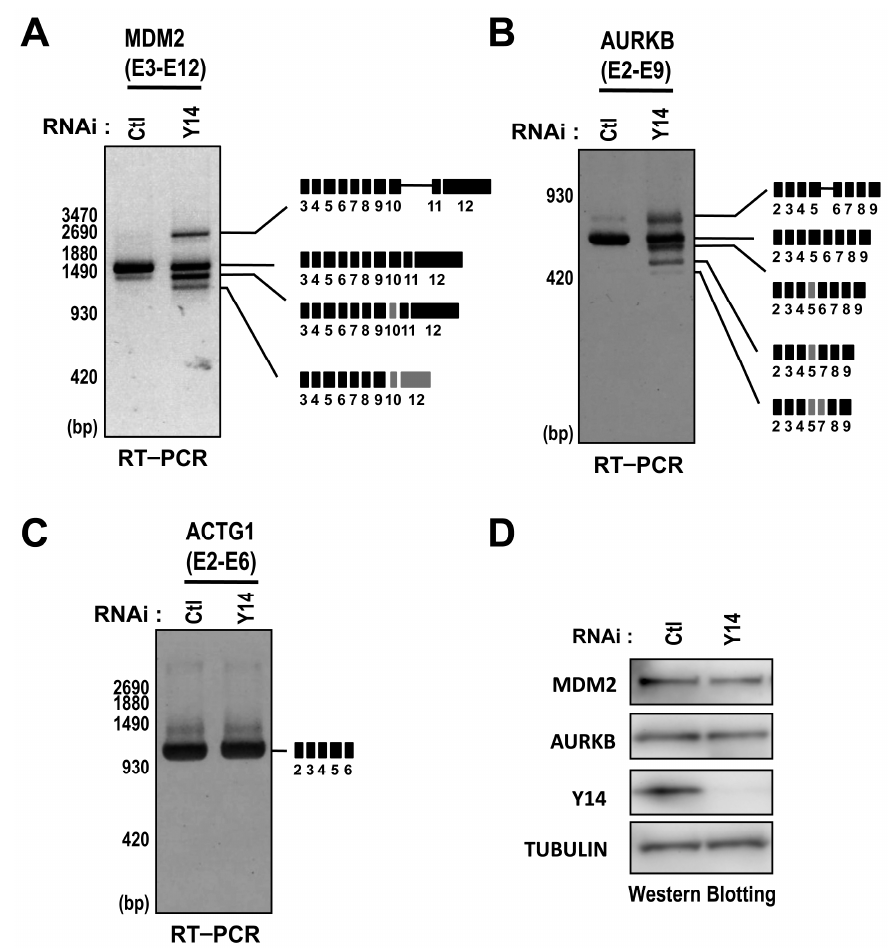
Figure 2. Y14 is required for faithful splicing of MDM2 and AURKB pre-mRNAs. ( A – C ) HeLa cells were transfected with control siRNA or Y14 siRNA and obtained total RNAs at 48 h post-transfection were analyzed by RT–PCR using primer sets for MDM2 ( A ), AURKB ( B ), and ACTG1 ( C ) transcripts. The RT–PCR products were subcloned and the sequences were verified. The schematic representation on the right indicates the corresponding mRNA products. Black boxes represent full-length exons and grey boxes represent truncated exons generated by alternative splice site usage; and ( D ) Western blot analysis of whole cell extracts of control siRNAs- or Y14 siRNA-treated HeLa cell using anti-Y14, anti-MDM2, anti-AURKB, and anti-TUBULIN antibodies.